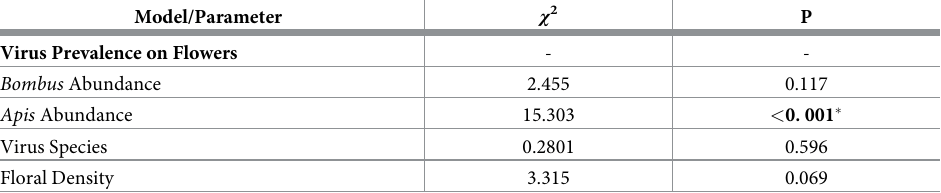
Table 3. Results of the GLMM for virus prevalence on flowering plants showing fixed effects tested. Prevalence is reported as the percentage of flowering plants with viruses detected. Bee abundance was measured as the number of bees (either honeybees or bumblebees) observed per m 2 . Virus species is either deformed wing virus (DWV) or black queen cell virus (BQCV). Floral density was calculated as the number of inflorescences per m 2 . Table shows chi squared value, degrees of freedom (Df) and p-value.